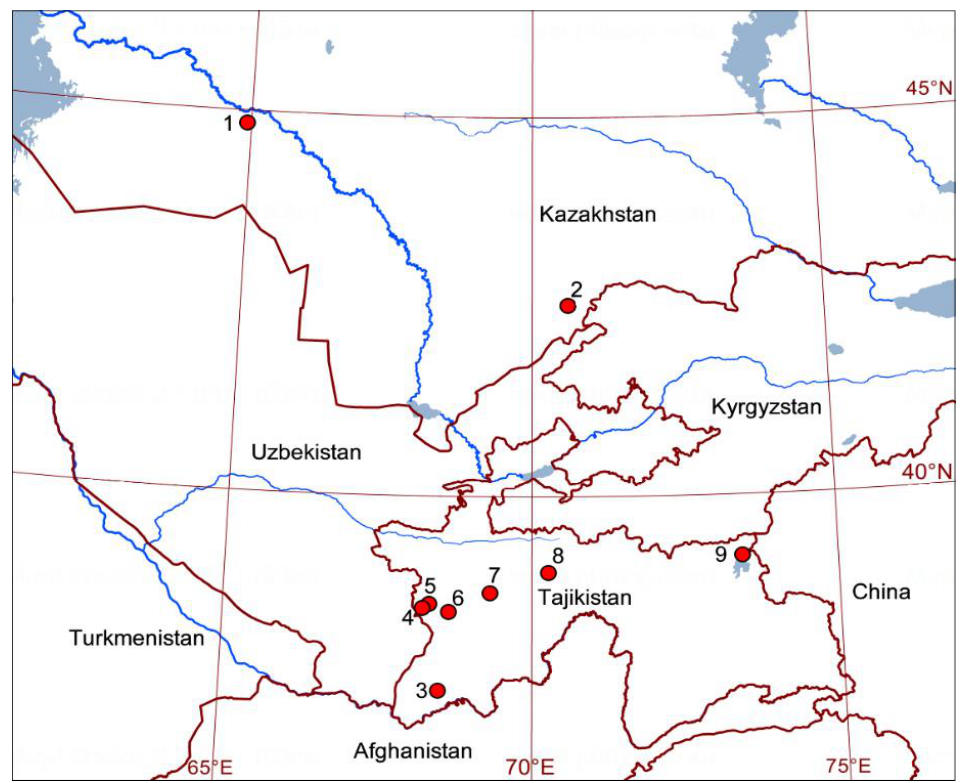
Figure 1. Collection sites of Pantala flavescens in Middle Asia. Designations are given in Table 1.